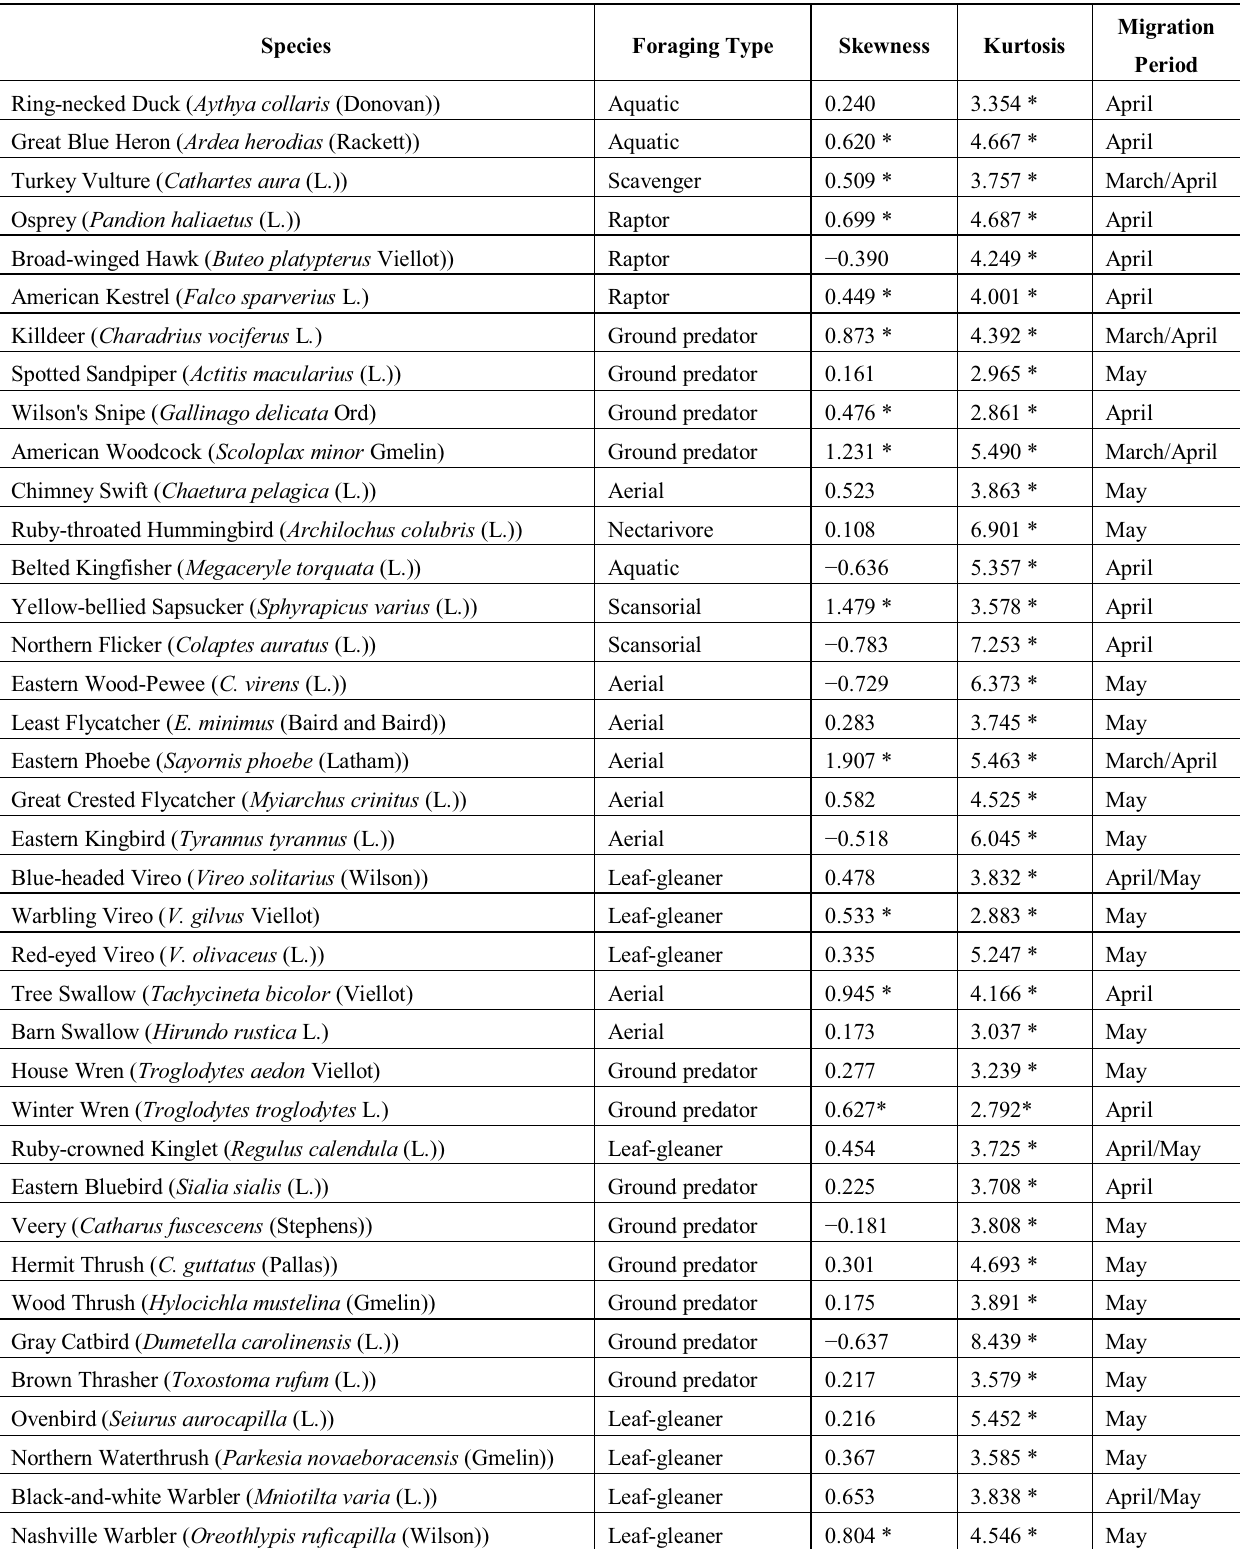
Table 1. Foraging types, skewness, kurtosis and major migration period of the 65 species used in this study. The skewness and kurtosis values are the mean of the 18 yearly values. An asterisk after particular skewness or kurtosis values indicates that the value is significantly different from zero in Wilcoxon rank tests using the Bonferroni correction to insure an experiment-wise p -value of